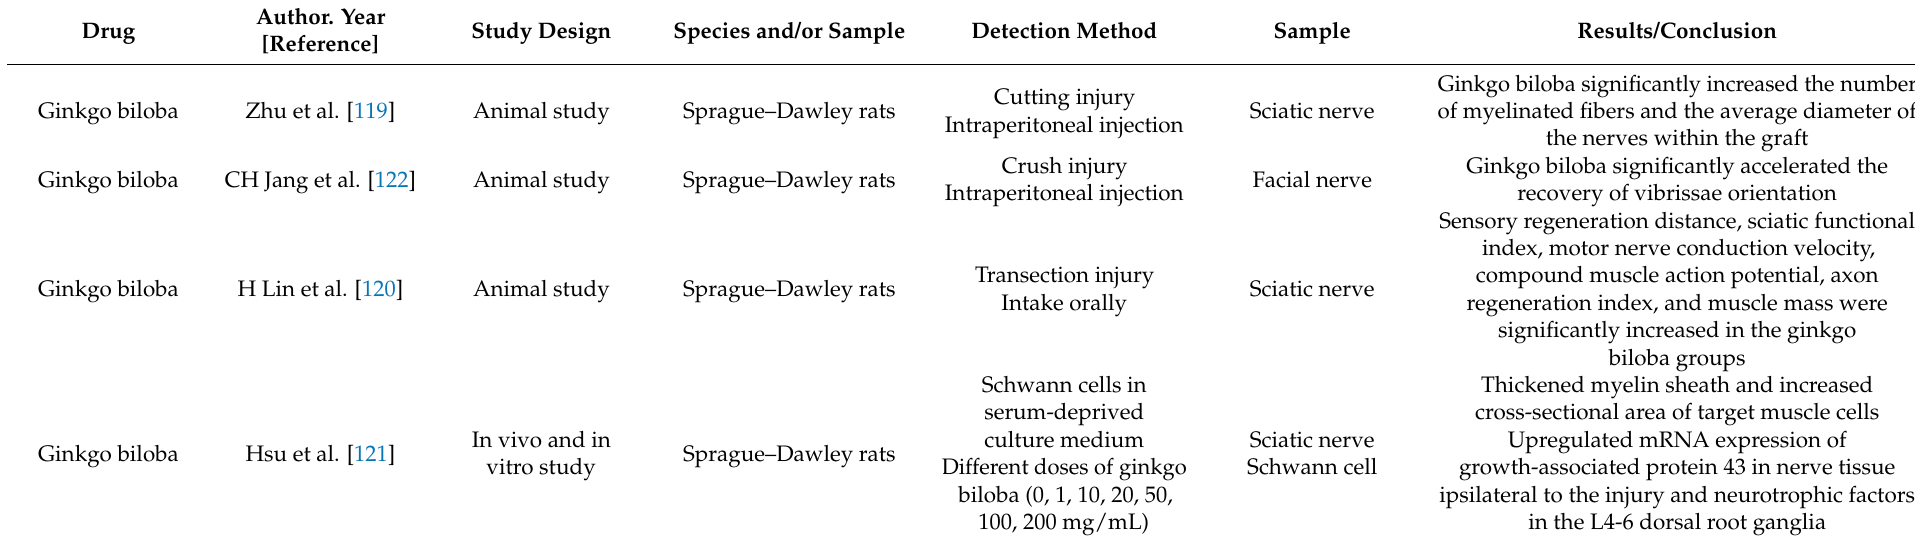
Table 8. Summary of studies evaluating Ginkgo biloba for the treatment of peripheral nerve